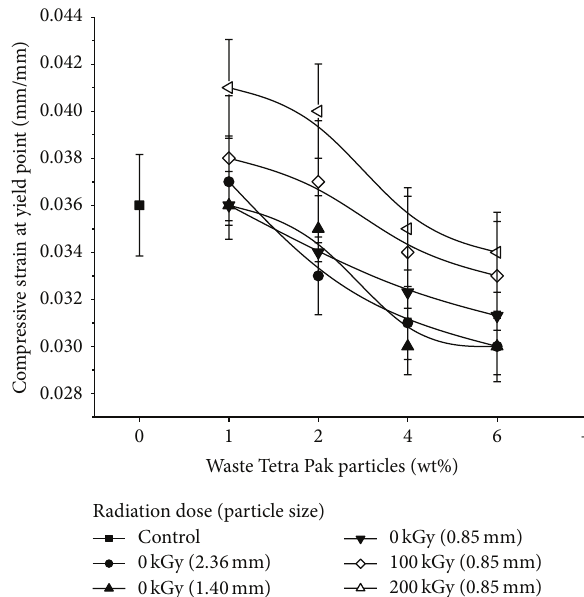
Figure 5: Compressive strain at yield point of concrete containing waste Tetra Pak particles.